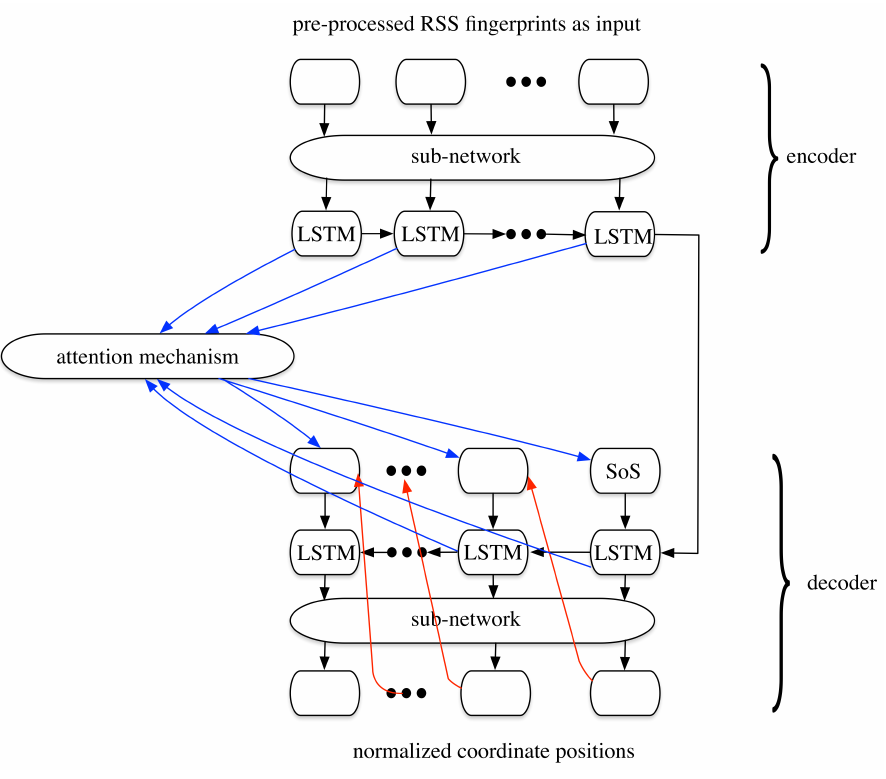
Figure 9. The network structure implemented in the proposed